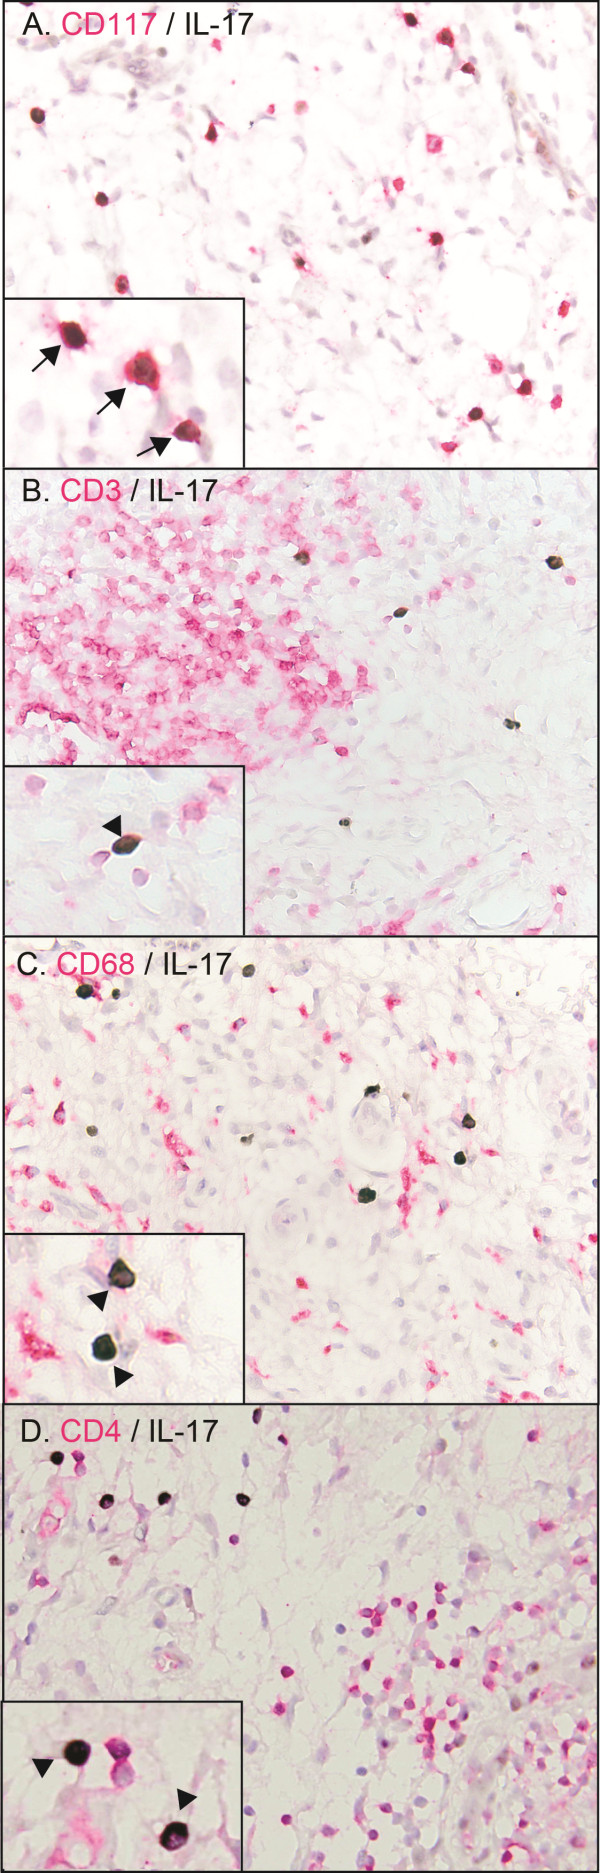
Expression of IL-17 by immunohistochemistry. (A) Double-staining of IL-17 (black) and CD117+ mast cells (pink). (B) Double-staining of IL-17 (black) and CD68+ macrophages (pink). (C) Double-staining of IL-17 (black) and CD3+ T cells (pink). (D) Double-staining of IL-17 (black) and CD4 (pink). Representative examples are shown. In insets in parts (A) through (D), arrows indicate double-positive cells and arrowheads indicate single IL-17+ cells. The magnification of inset images are made digitally, and are 2× the magnification of the original figure which is made through a 400× magnification.